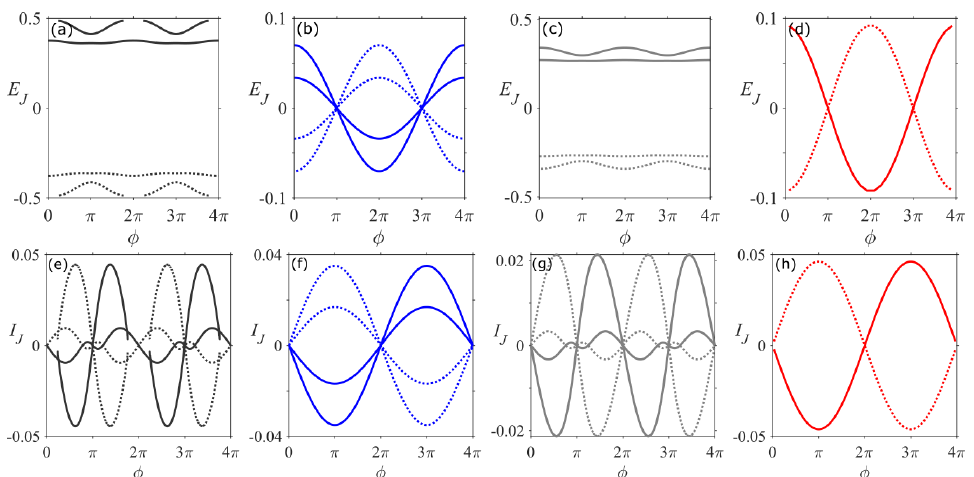
( φ ) and (e)-(h) Josephson Current I ( φ ) for Figure 5: (a)-(d) Josephson Energy E J J the midgap states at representative points in the four different regions labelled I − IV in Fig. 2. The red and blue curves cross E = 0 at φ = π and 3 π , and have a periodicity of 4 π . On the other hand, the dark gray and light-gray curves are far away from E = 0 for all values of φ . These lie in the non-topological regions I and III respectively, where the zero-energy modes are not allowed. Here the periodicity is found to be 2 π . These observations are found to be true for various strengths / transparencies of the barrier separating the two sides of the Josephson